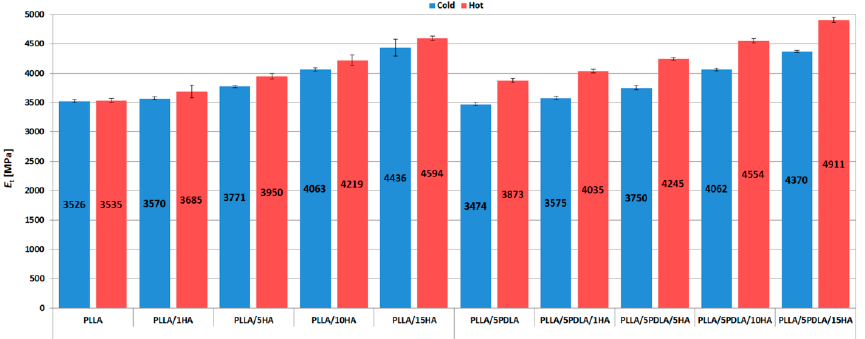
Figure 3. Tensile modulus plots of samples from cold and hot molds. Table 3. Non-isothermal crystallization data of samples from hot mold (100 °C).